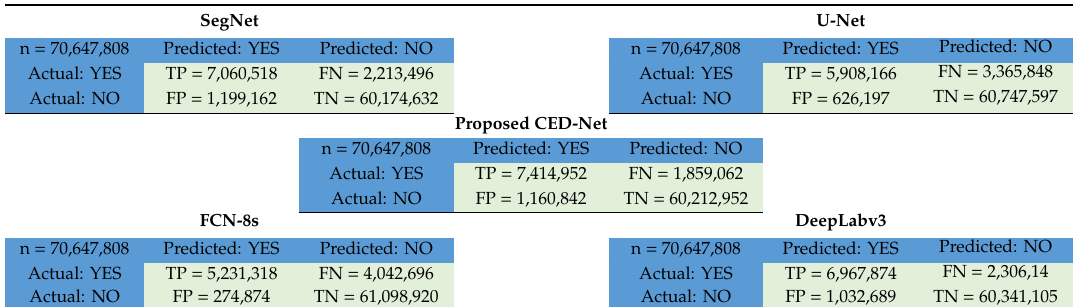
Figure 4. Qualitative comparison of results of semantic segmentation for rice seeding and weed dataset. Table 4. Confusion matrices of SegNet, U-Net, FCN-8s, DeepLabv3, and proposed CED-Net for rice seeding and weed dataset.